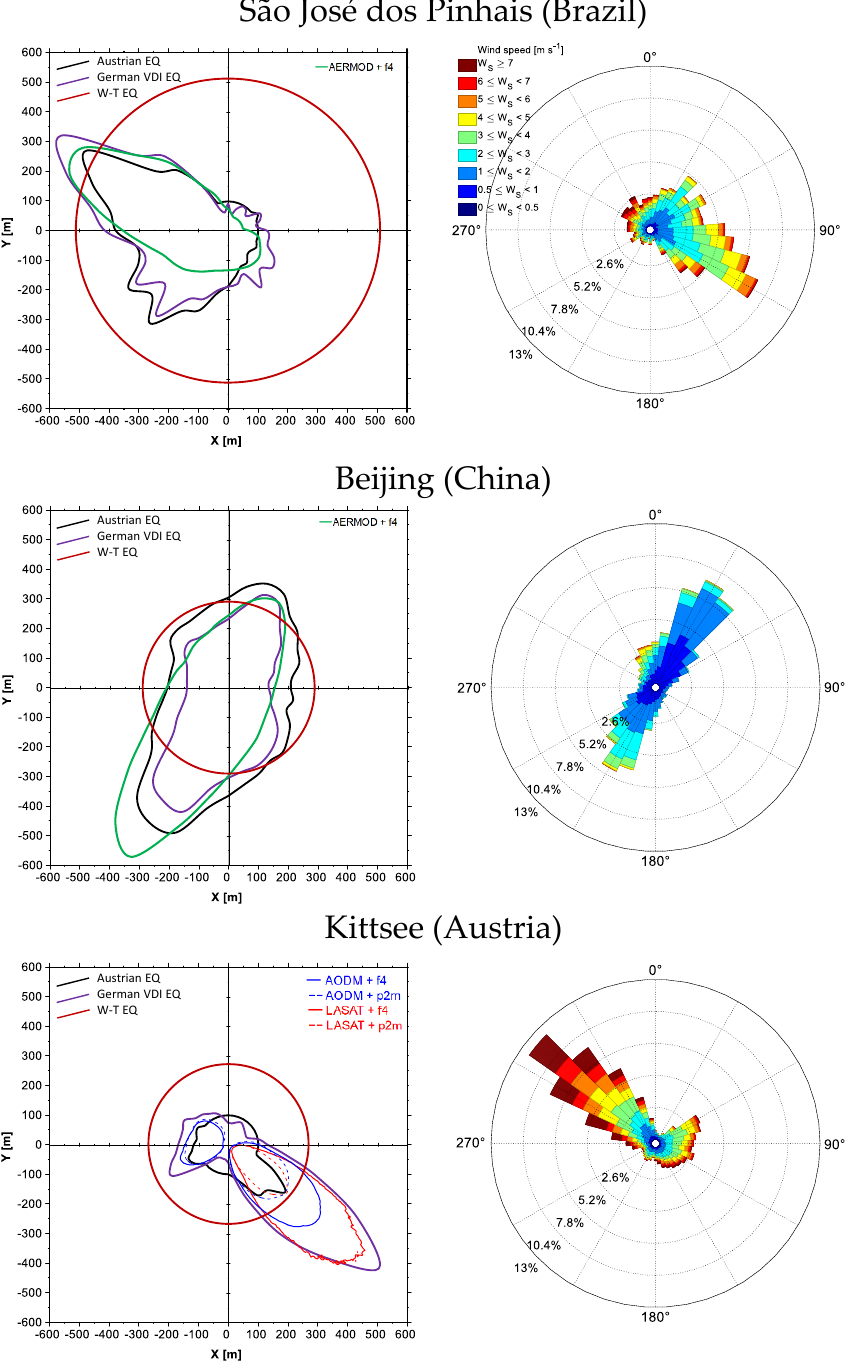
Figure 2. Separation distances calculated using the German VDI, the Austrian, and the W-T EQs against dispersion models for the three case studies under investigation and their respective wind roses.